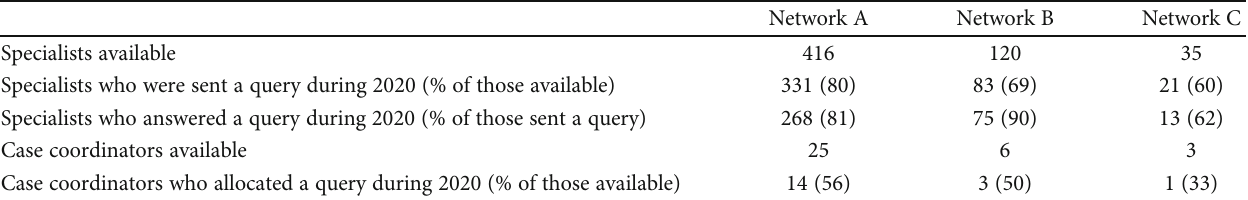
Table 9: Resources (numbers of specialists and case coordinators) available during the fi rst six months of 2020.